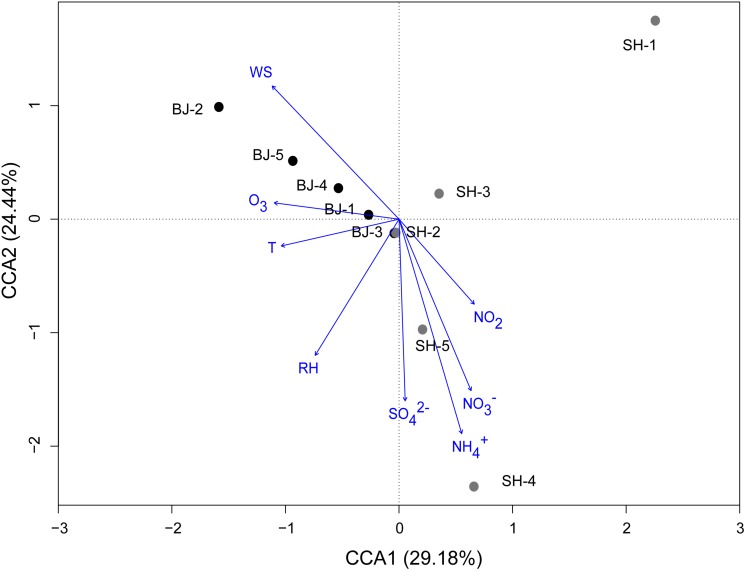
Canonical correspondence analysis (CCA) of bacterial community structures (OTUs) from 10 PM2.5 samples with respect to the eight environmental and meteorological variables. Arrows indicate the direction and magnitude of measurable variables associated with community structures.